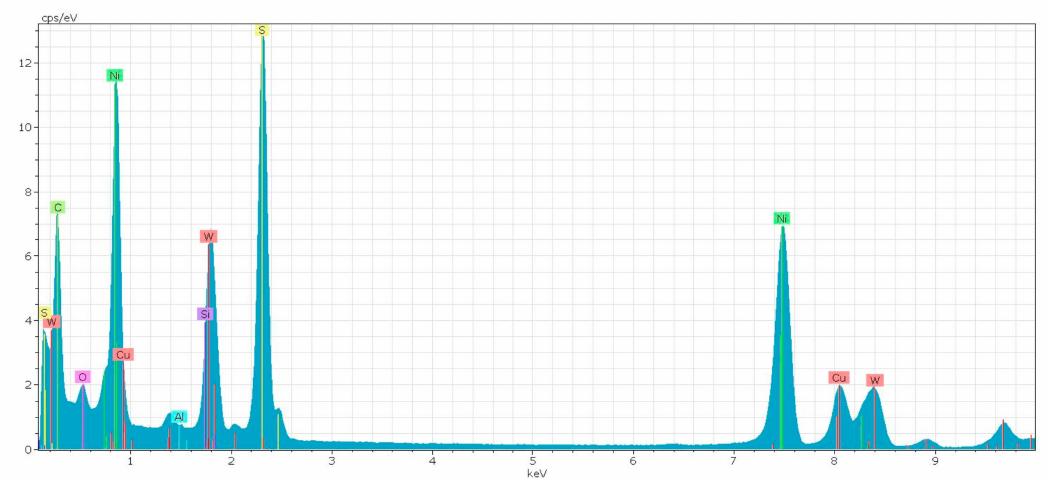
Figure A2. EDX spectrum of catalyst NiWS-HY